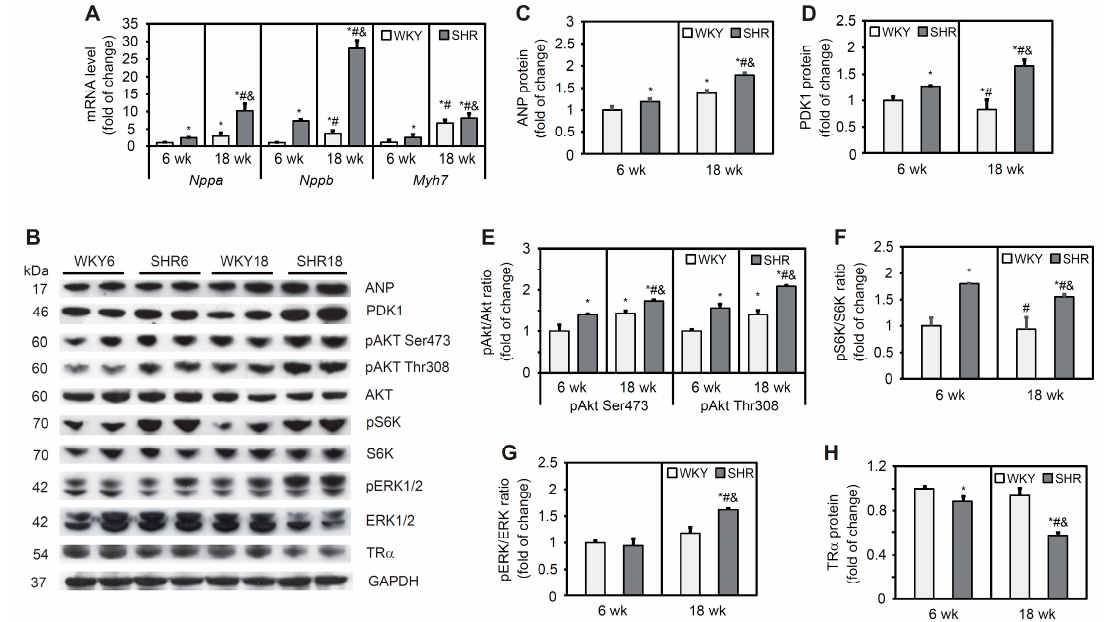
Figure 1. Molecular signaling pathways of cardiac remodeling in SHRs. Nppa , Nppb , and